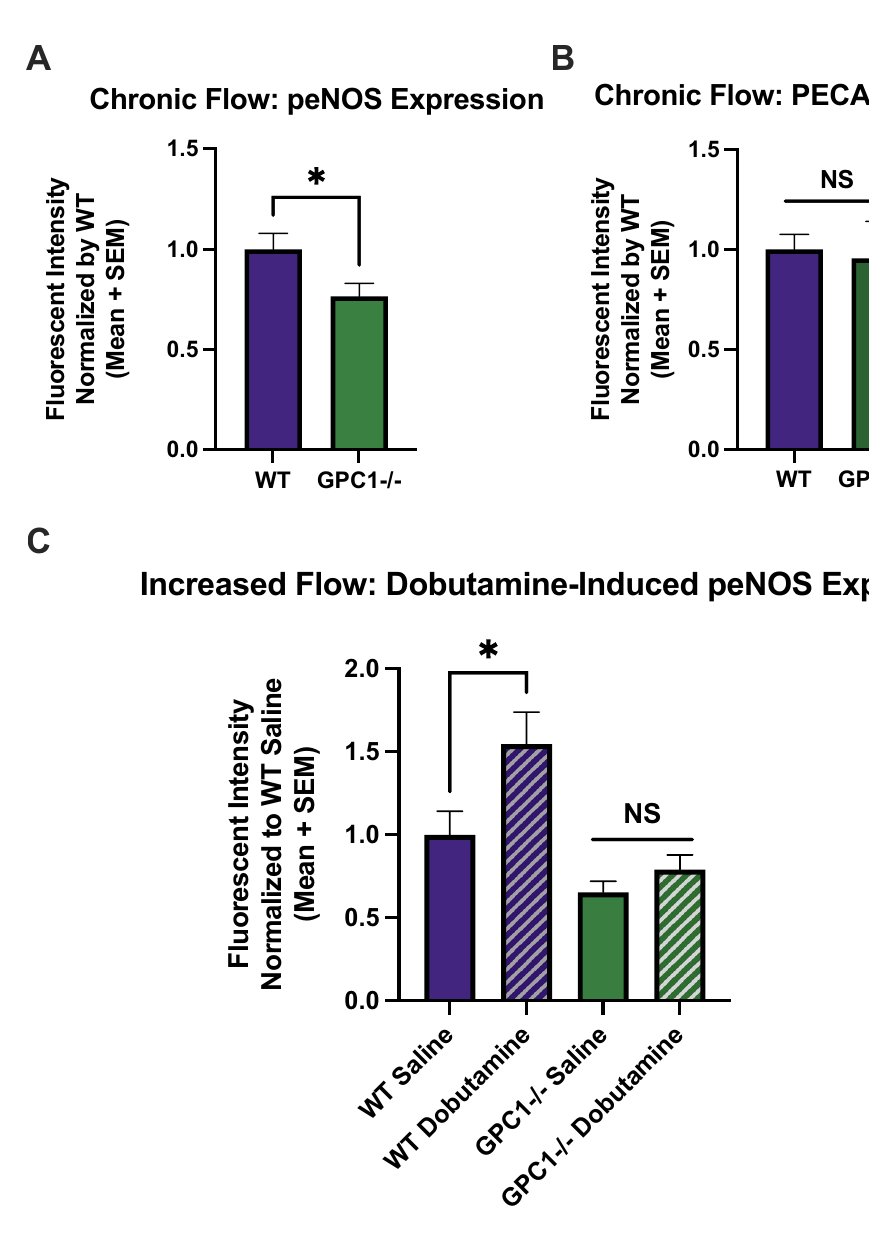
Figure 2. Glypican-1 knockout mice have inhibited eNOS phosphorylation in both chronic and increased flow conditions. Descending aorta from WT and Gpc1−/− mice were en face immunostained for peNOS and PECAM-1. ( A ) Mean normalized peNOS expression under chronic flow is shown for WT (n = 10) and Gpc1−/− mice (n = 10). *P < 0.05 using two-tailed student’s t-test. ( B ) Mean normalized PECAM-1 expression under chronic flow is shown for WT (n = 6) and Gpc1−/− (n = 5) mice. *P < 0.05 using two-tailed student’s t-test. ( C ) Mean normalized peNOS expression under increased flow induced by dobutamine for 30 min is shown for WT (n = 9 and 8 for saline and dobutamine groups, respectively) and Gpc1−/− mice (n = 8 for both saline and dobutamine groups). *P < 0.05 using one-way ANOVA followed by Sidak’s multiple comparisons